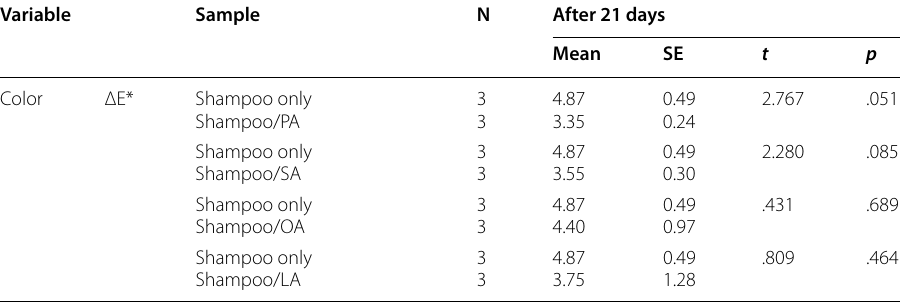
Table 13 T-test comparison of color change after 21 days of treatment between BH shampooed only and BH shampooed with fatty acid conditioners Variable